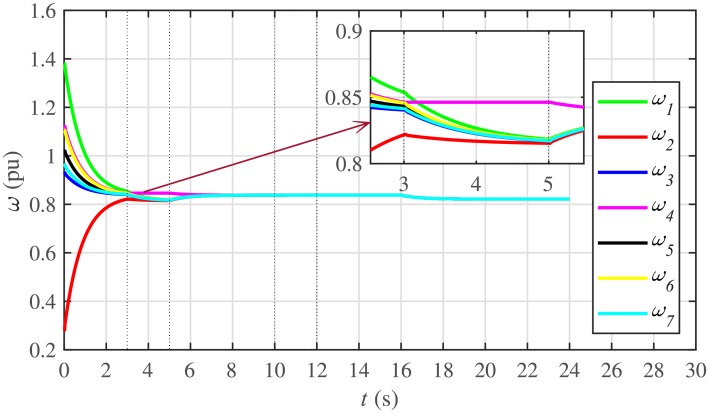
Frequency regulation under case 6. [27].